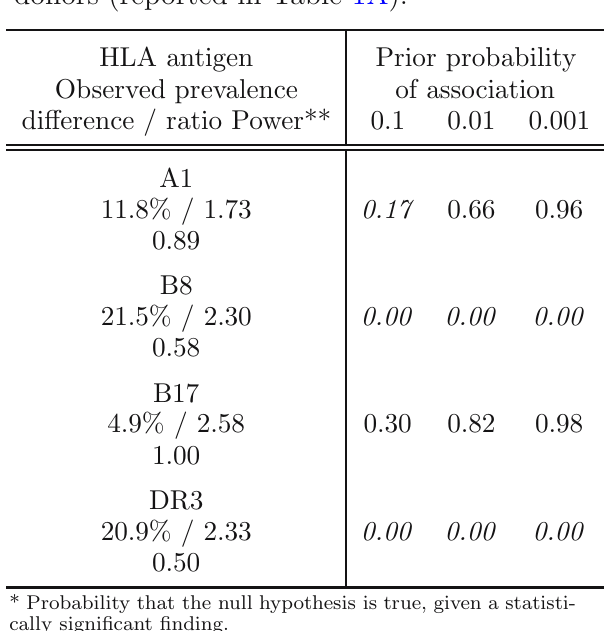
Table 2A False positive report probability (F*) values to test the observed statistically significant differences/ratios in the phenotype prevalences of HLA antigens between PSC patients and healthy donors (reported in Table 1A).